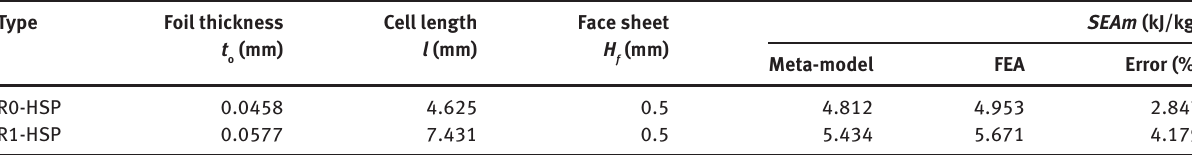
constraint (1.21 peak